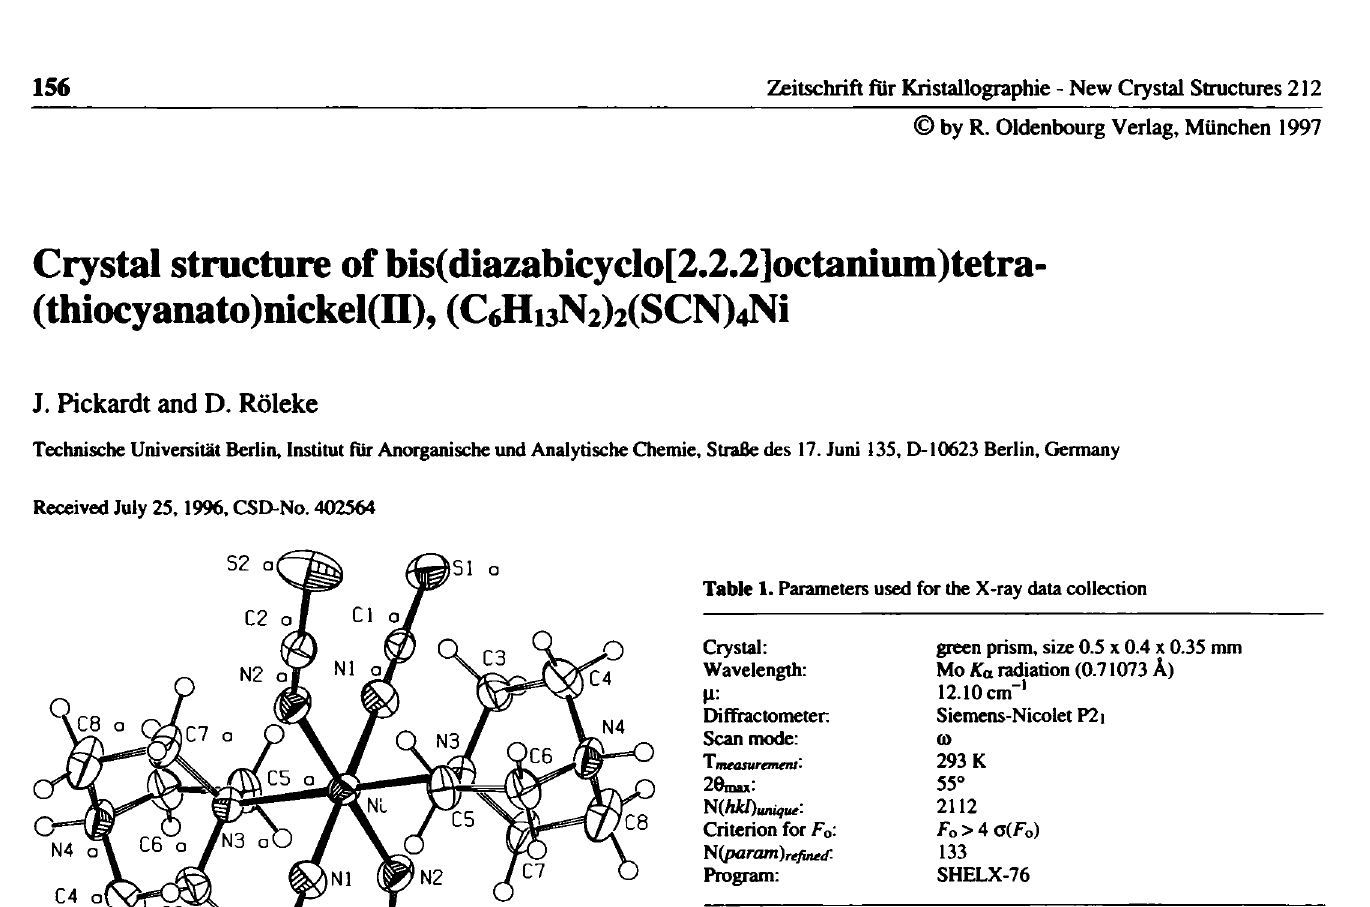
Table 2. Final atomic coordinates and displacement parameters (in Â 2